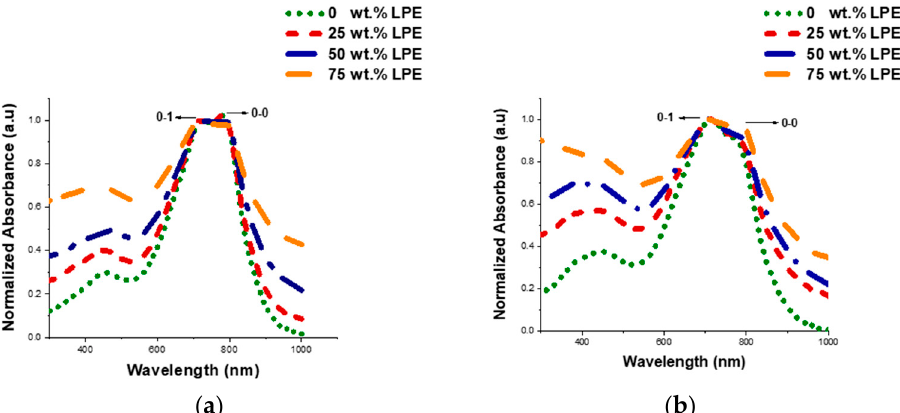
Figure 1. UV-vis spectra of P(DPPTVT) blends with 0–75 wt.% LPE of thin films: ( a ) before annealing and ( b ) after thermal annealing at 150 °C for 30 min. Thin films were prepared by solution deposition (spin coating) on a glass slide.